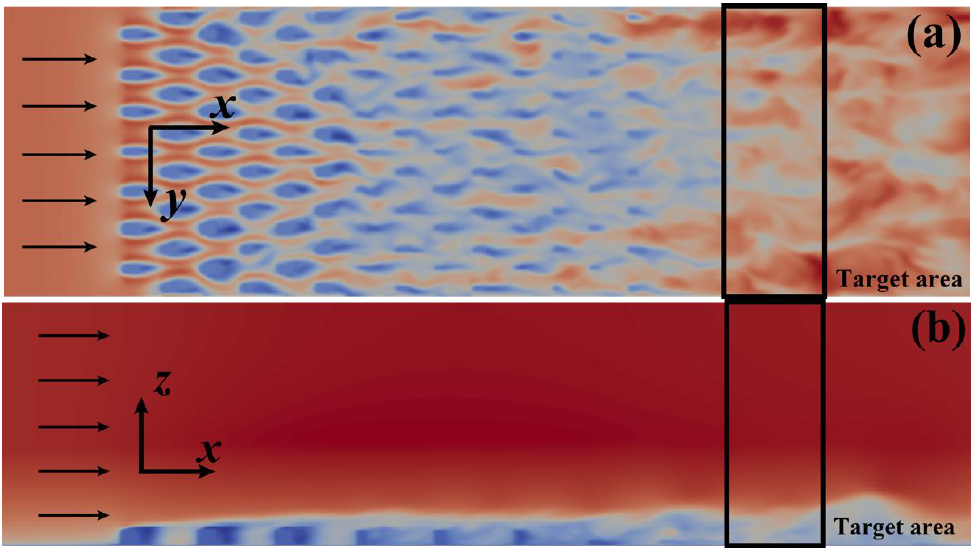
Figure 4. Streamwise velocity field ( a ) in the near ground at height = 0.05 m and ( b ) in the crosswise central plane. The colors from blue to red represent the streamwise velocity from zero to high value. The velocity field in the target area is used for reshaping inflow velocity profile.